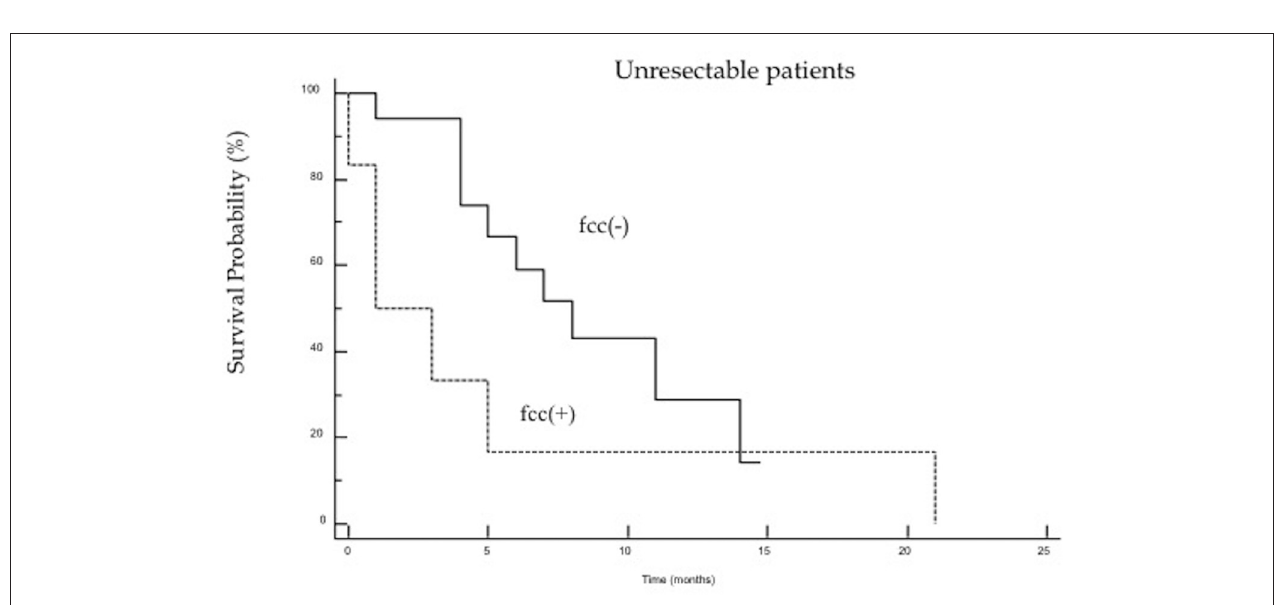
FIGURE 2 | The Kaplan–Meier survival curves for resected patients, comparing patients with fcc ( + ) [HR7.799 (95% CI: 1.693–35.915)] and fcc (–) [HR.128 (95% CI: 0.027–0.590), p < 0.0001].